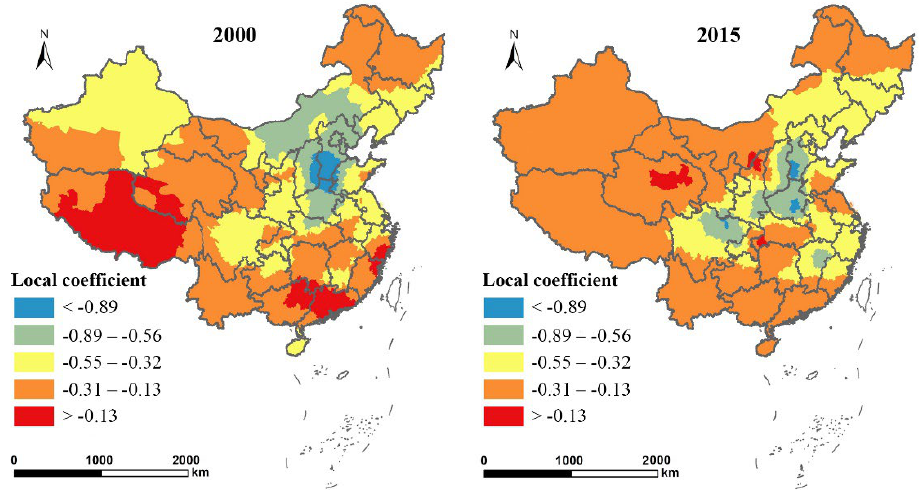
Figure 6. Spatial distribution of the local coefficients of urban economic density (ln ED ) in 2000 and 2015.